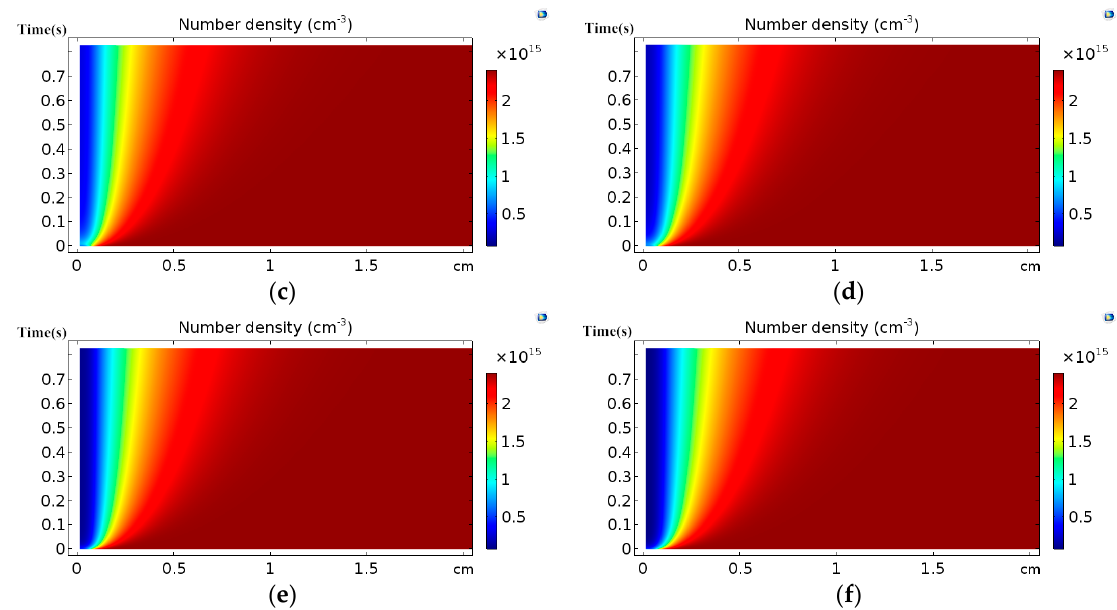
Figure 8. Effect of temporal and spatial evolution of number density of SO 2 : ( a ) − 25 KV; ( b ) − 30 KV; ( c ) − 35 KV; ( d ) − 40 KV; ( e ) − 45 KV; and ( f ) − 50 KV.